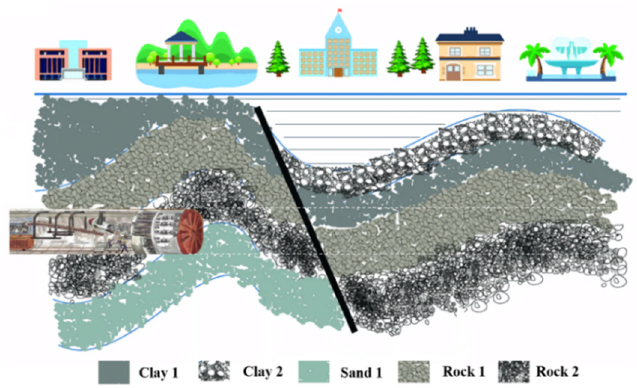
Figure 2. Longitudinal geological profile of a tunnel. Reproduced with permission from [11], IEEE, 2019.